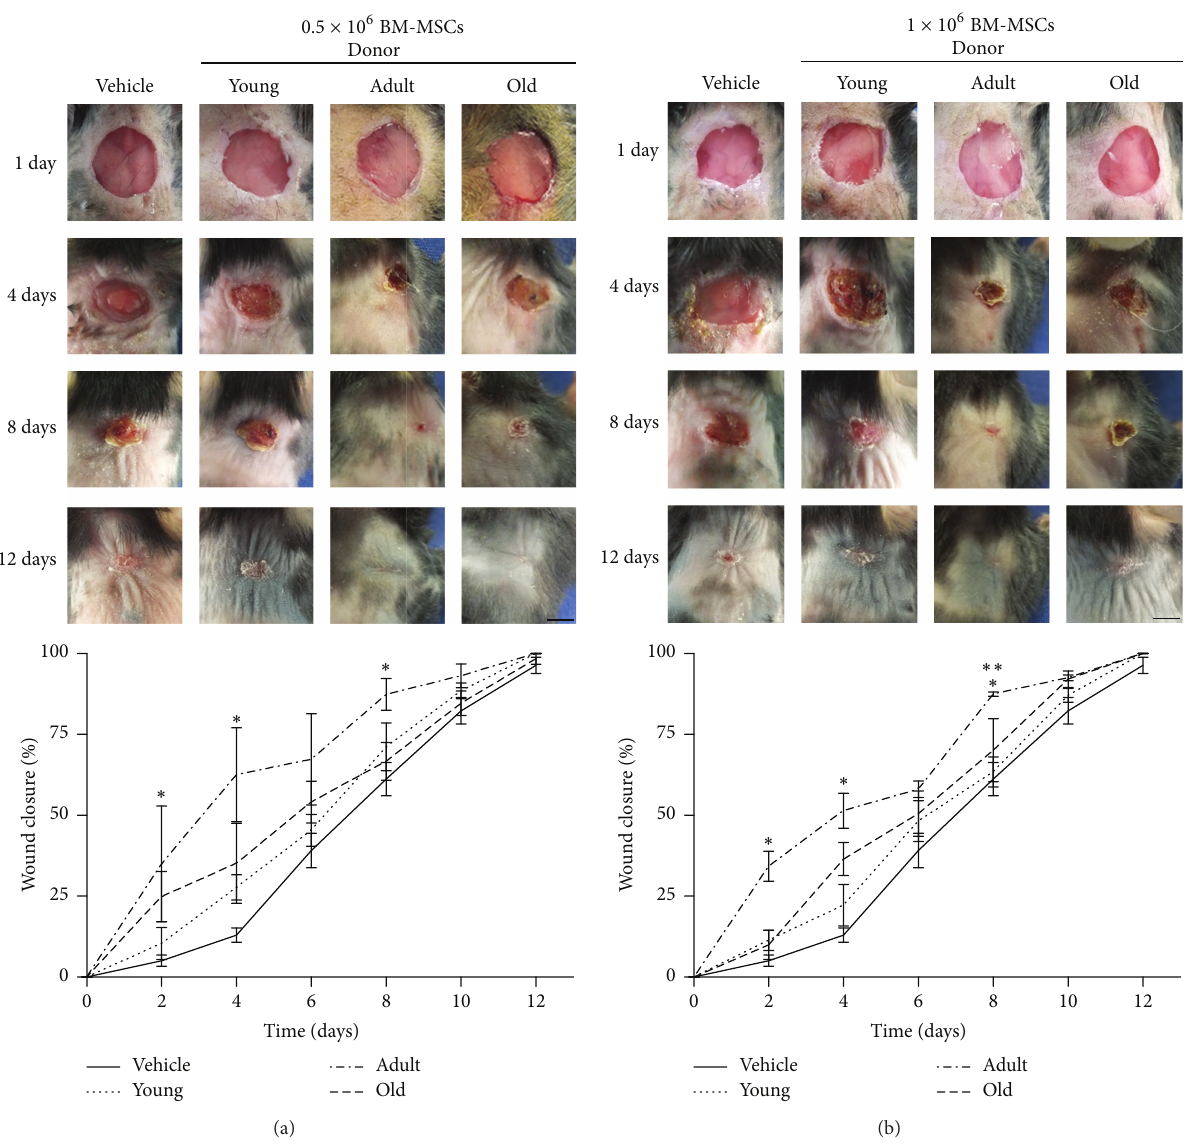
Figure 1: Adult donor syngeneic BM-MSCs accelerated wound closure kinetics. A murine excisional wound model in which wounds were treated with (a) 0.5 × 10 6 and (b) 1 × 10 6 BM-MSCs isolated from female young, adult, and old C57BL/6 or 5% autologous plasma in physiological saline (vehicle). Representative photographs of wounds in C57BL/6 before treatment or 4, 8, and 12 days afterwards. Wound size measurement at different times. Data are mean ± SEM (vehicle (𝑛 = 15) ; 0.5 × 10 6 BM-MSCs isolated from young ( 𝑛 = 6 ), adult ( 𝑛 = 6 ), and old ( 𝑛 = 6 ) and 1 × 10 6 BM-MSCs isolated from young ( 𝑛 = 7 ), adult ( 𝑛 = 6 ), and old ( 𝑛 = 6 )). ANOVA ∗ (𝑝 < 0.05) : young, adult, and old versus vehicle. ANOVA ∗∗ (𝑝 < 0.001) : adult versus young and